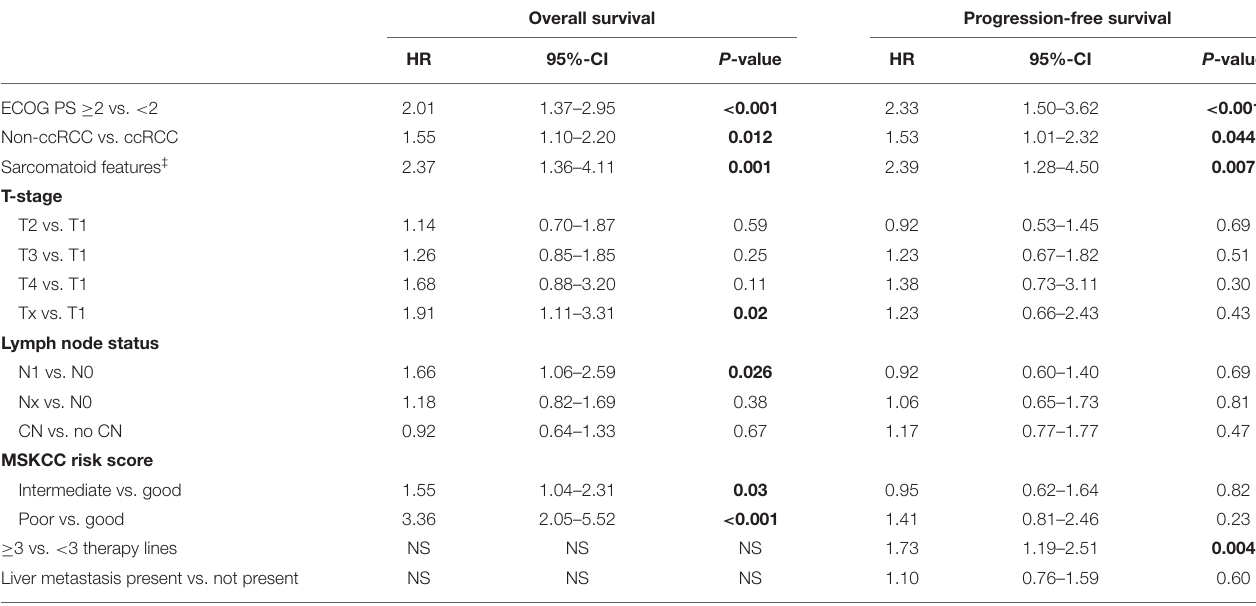
TABLE 2 | Multivariable analyses of overall and progression-free survival in patients with mRCC treated with TKIs † . Overall survival Progression-free survival